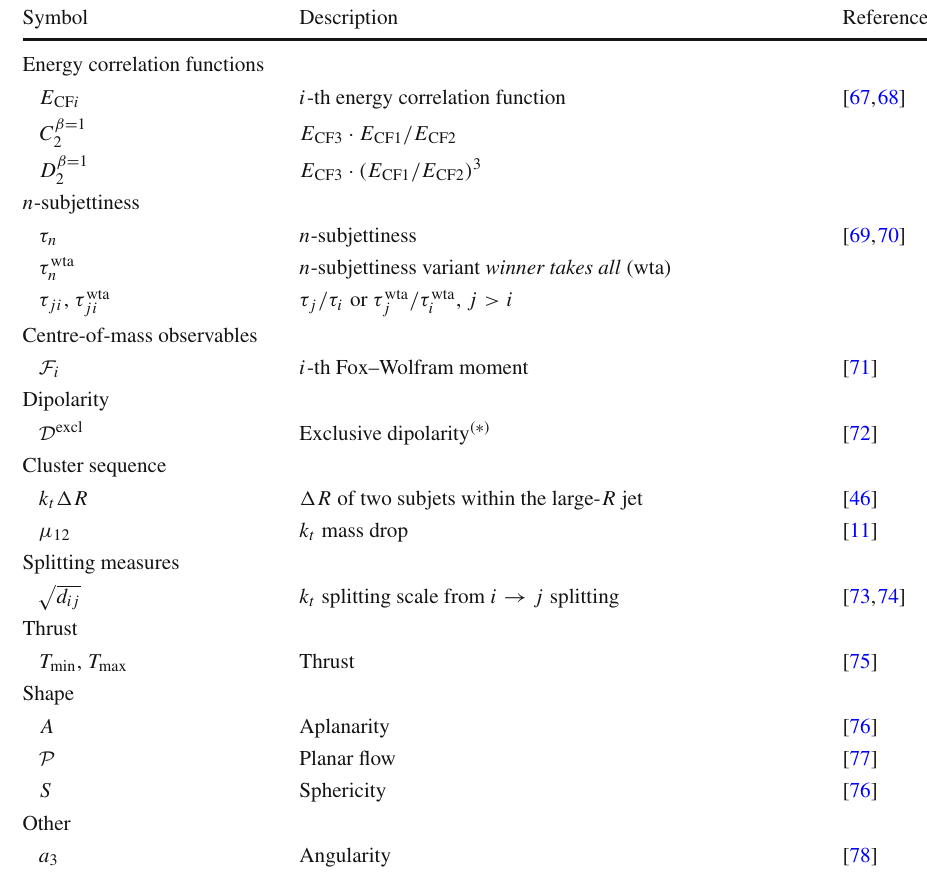
substructure variables. A short description of these substructure variables can be found in Refs. [65,66]. ( ∗ ) Exclusive dipolarity forces the jet to have exactly two subjets from the k t algorithm to begin with, which is different from the dipolarity, which runs k t clustering and then takes all jets with p T above 5